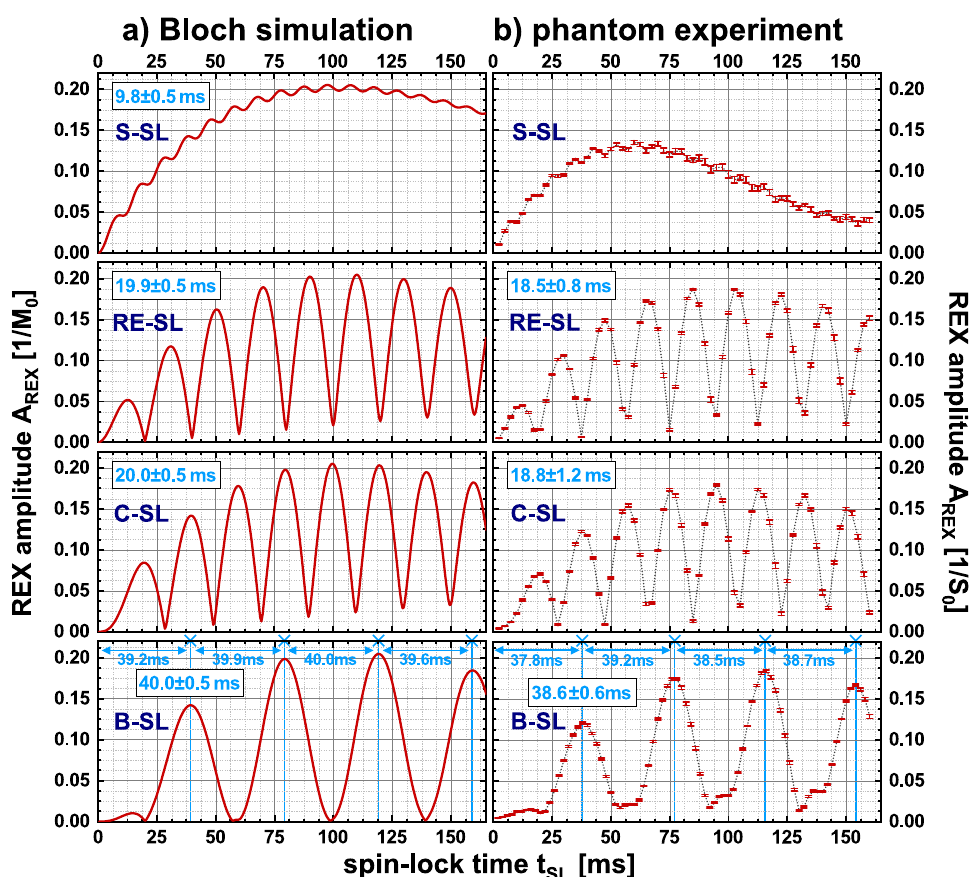
Figure 5. Experimental verification of Bloch simulation t SL characteristics in the phantom experiment. In ( a ), the results of the Bloch simulation are plotted. ( b ) The A REX amplitudes experimentally determined by a t SL variation measured in the Agarose phantom. Here, t SL was varied from 0…160 ms for each preparation module. To achieve feasible measurement times, six relative phases ϕ were varied per amplitude calculation. The respective Δt SL periods are noted in blue. Due to the low amplitude of the oscillation, no period duration was determined for the phantom results of the S-SL module. The qualitative behavior of A REX maxima could be observed in the phantom measurements in good agreement with the simulation results. The period lengths of the measurements are slightly smaller than in the simulation, which could be due to a deviation of the actual spin-lock amplitude ( B + 1 inhomogeneity). In the simulation and experiment, the periods are shortest for S-SL and doubled for RE-SL and C-SL. The period of B-SL is